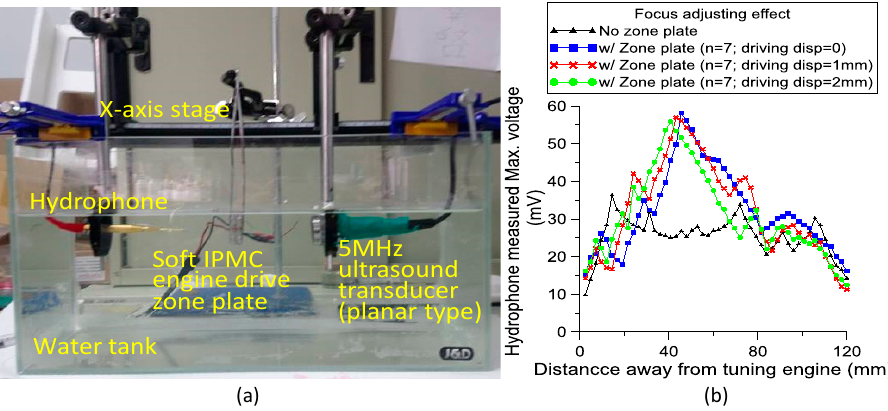
Figure 11. ( a ) Experimental setup for characterizing ultrasonic pressure while planar ultrasonic beam passing through the soft engine driven zone plate. ( b ) Measured maximum voltage output from hydrophone as a function of distance.